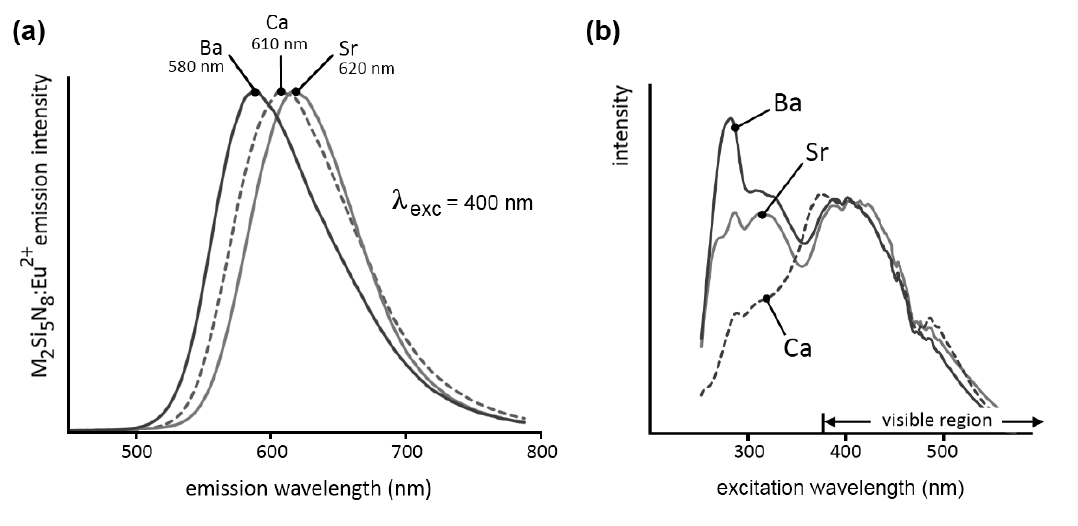
Si N :Eu (M = Ca,Sr,Ba). The 2 5 8 = 400 nm. The excitation spectra were recorded for exc